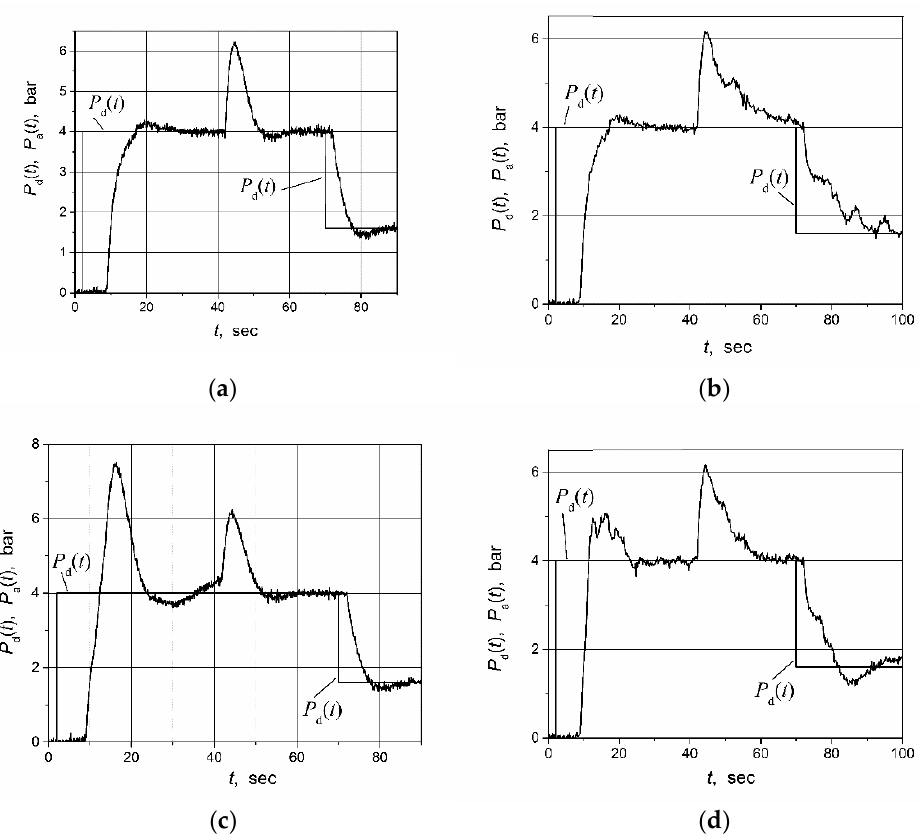
Figure 15. The water pressure set-point P d ( t ) pulse (set point 4 bar step followed by drop up to 1.6 bar) and load-disturbance responses of the water-supply control system. The system is based on the PI controller with the switched-delay Smith predictor ( a ) and the classical Smith predictor ( b – d ). The delays in the model of the switched-delay Smith predictor were adjusted to values T r = 7 s and T f = 2 s, and in the classical Smith predictor to values ( b ) T m = 7 s; ( c ) T m = 2 s; ( d ) T m = 4.5 s. The PI controller parameters in both control systems were tuned to values K p = 0.85 and K i = 0.57, the transfer function of the water-supply system model used in both controllers was G m (s) = 1/(1.7 s + 1).